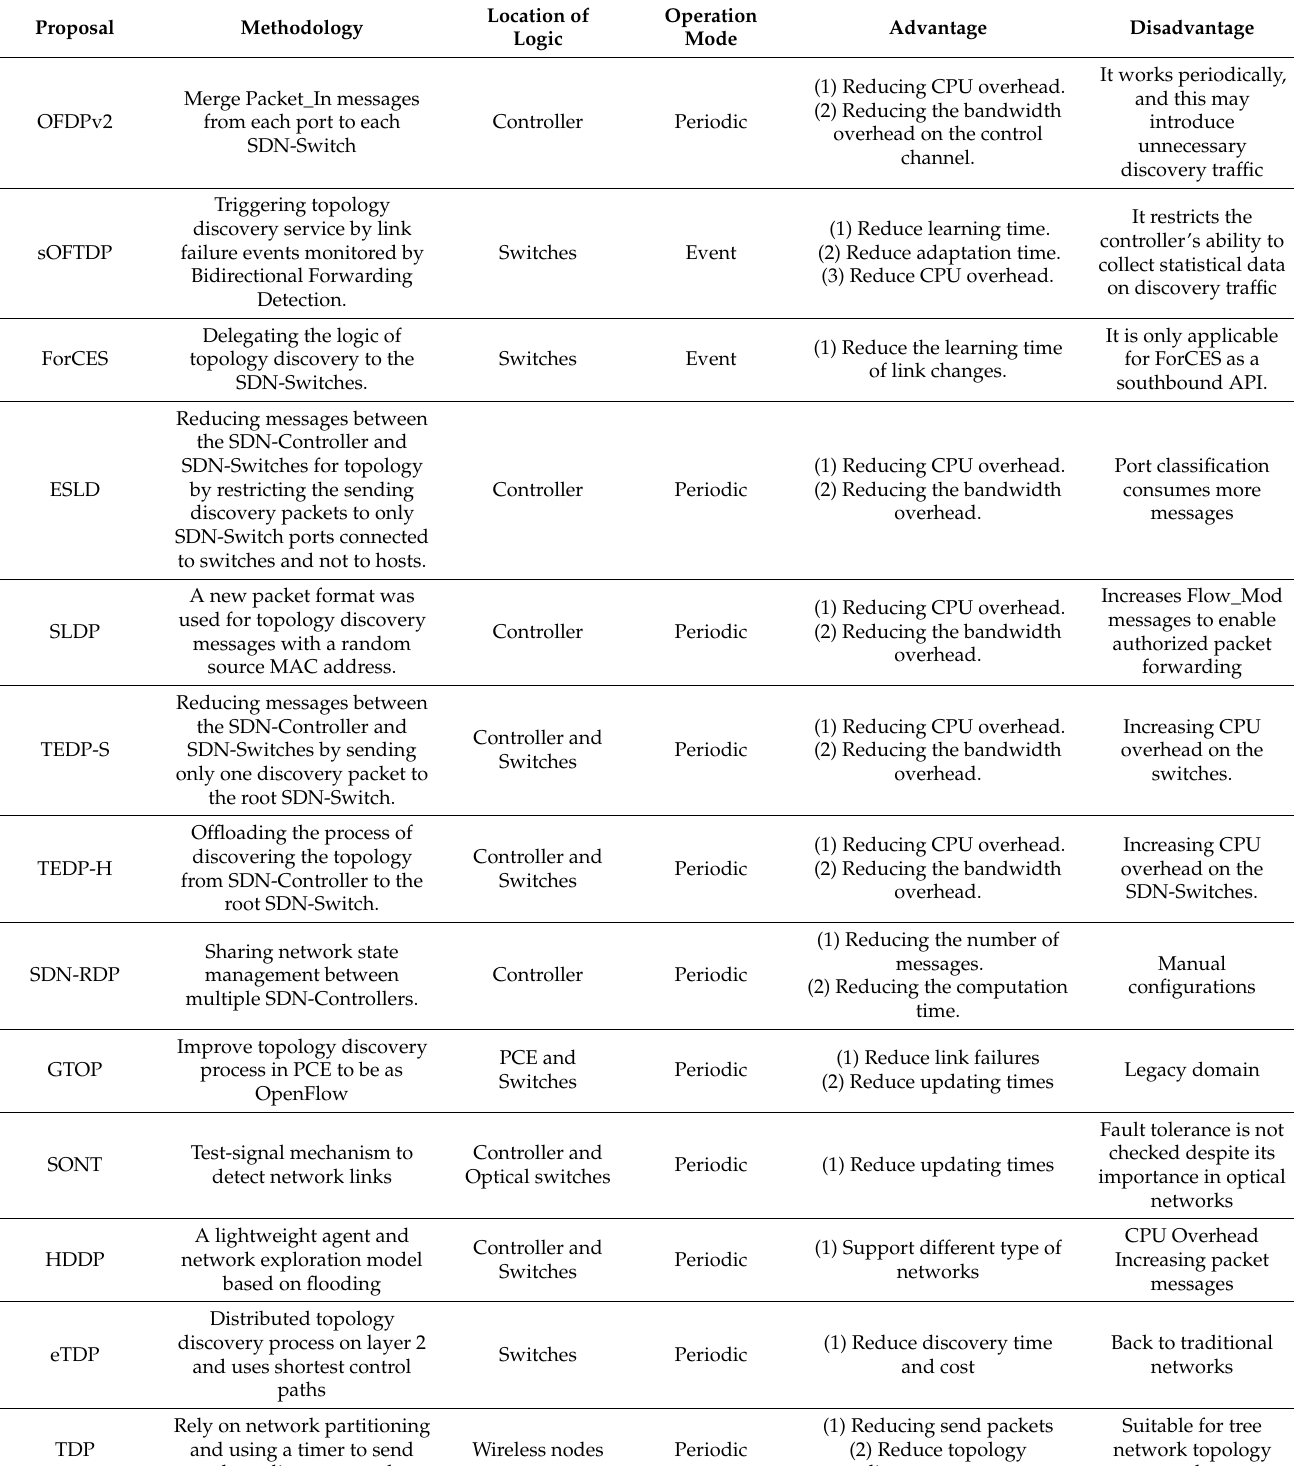
Table 4. Comparison between different proposed approaches to enhance